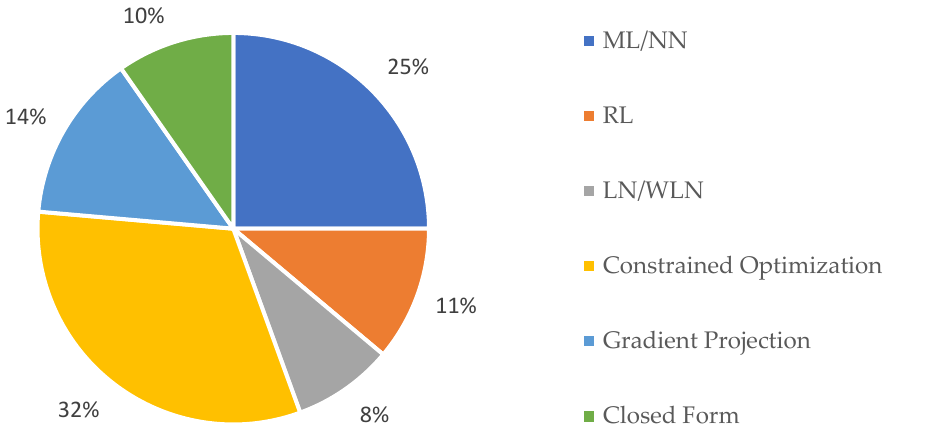
Figure 3. Percentage of research articles describing the redundancy resolution methods.